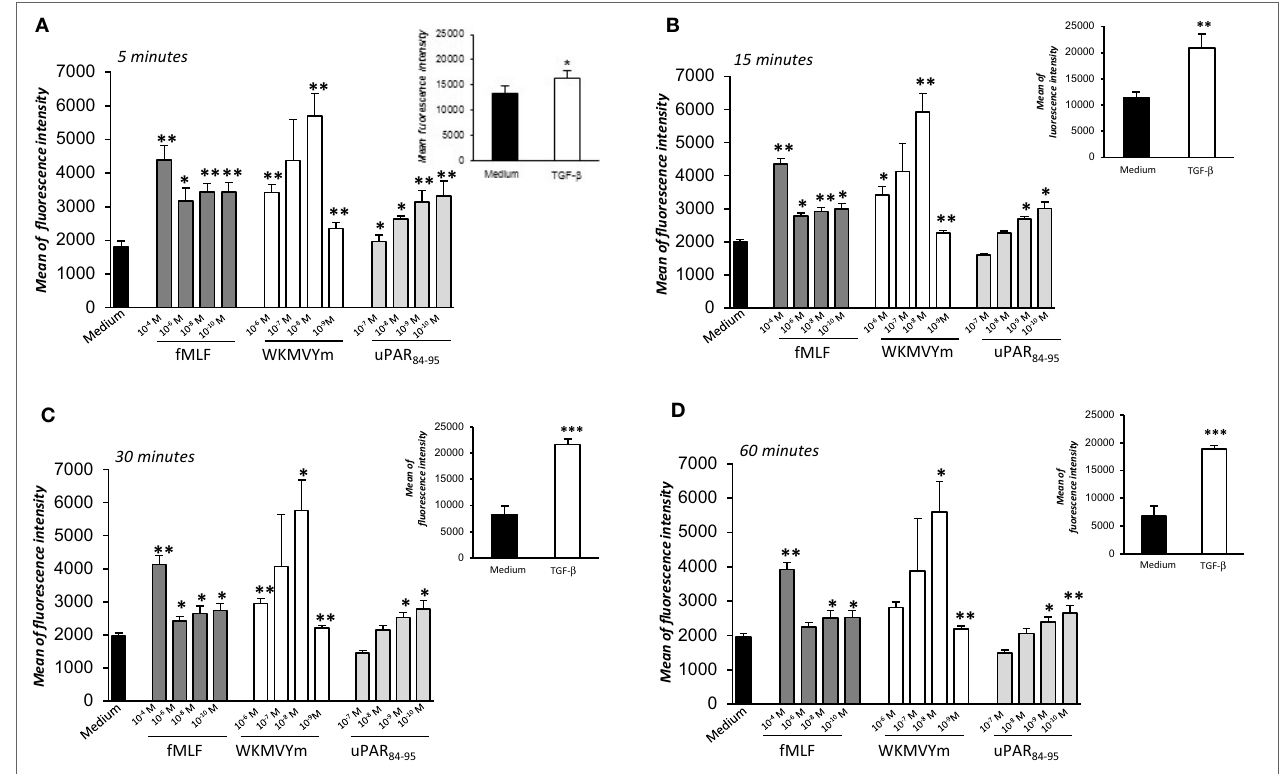
FigUre 2 | Effects of N -Formyl- l -methionyl- l -leucyl- l -phenylalanine (fMLF), WKYMVm peptide, and uPAR 84–95 on reactive oxygen species (ROS) production in BJ cells. Cells were plated in a 96-well plate and treated with DCHF-DA. At the end of incubation, cells were treated with medium alone (black columns), fMLF (dark gray columns), WKYMVm peptide (white columns), and uPAR 84–95 peptide (light gray columns). ROS release was measured as dichlorofluorescein (DCF) fluorescence intensity at 5, 15, 30, and 60 min (a–D) . Results are expressed as mean fluorescence intensity of DCHF-DA-loaded cells. DCHF-DA-loaded unstimulated cells and TGF- β stimulated cells were examined in parallel, as controls, and are shown in insets. Values are the mean ± SEM of three experiments performed in triplicate. * p < 0.05; ** p <